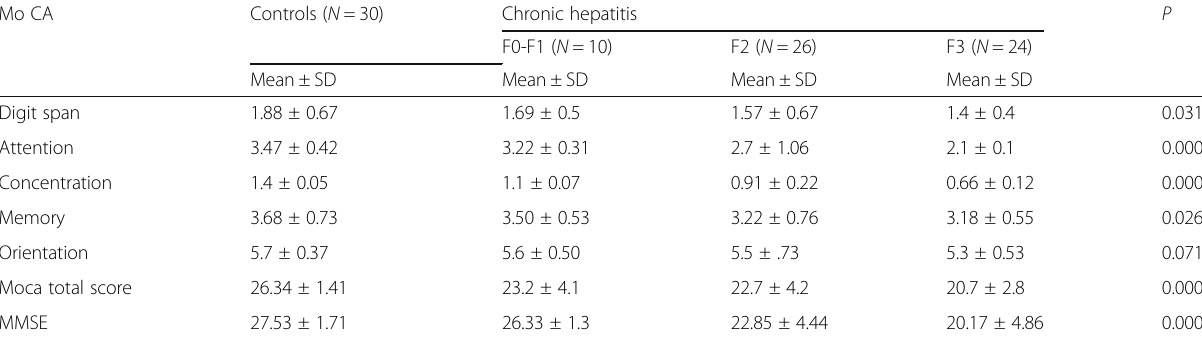
Table 3 Comparison between patients with HCV and controls as regards MoCA and MMSE Mo CA Controls ( N = 30)